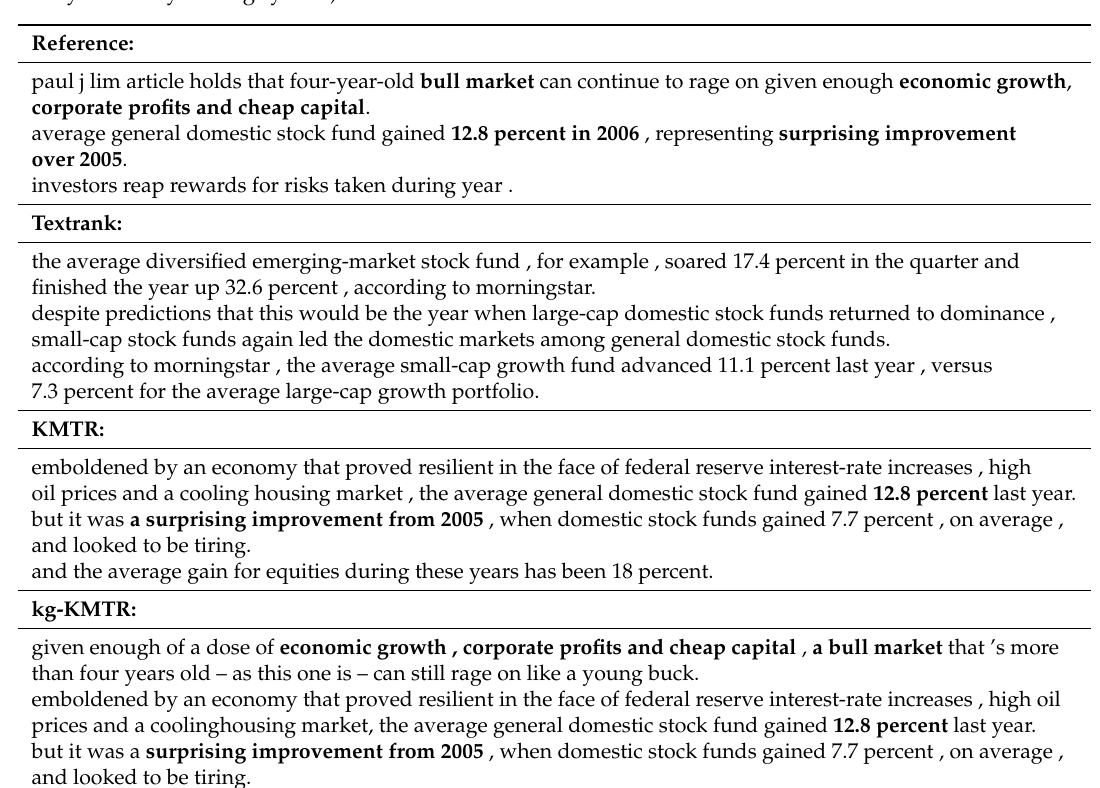
Table 3. Examples of generated summaries on the NYT data set. (The words in red are entities found by the entity linking